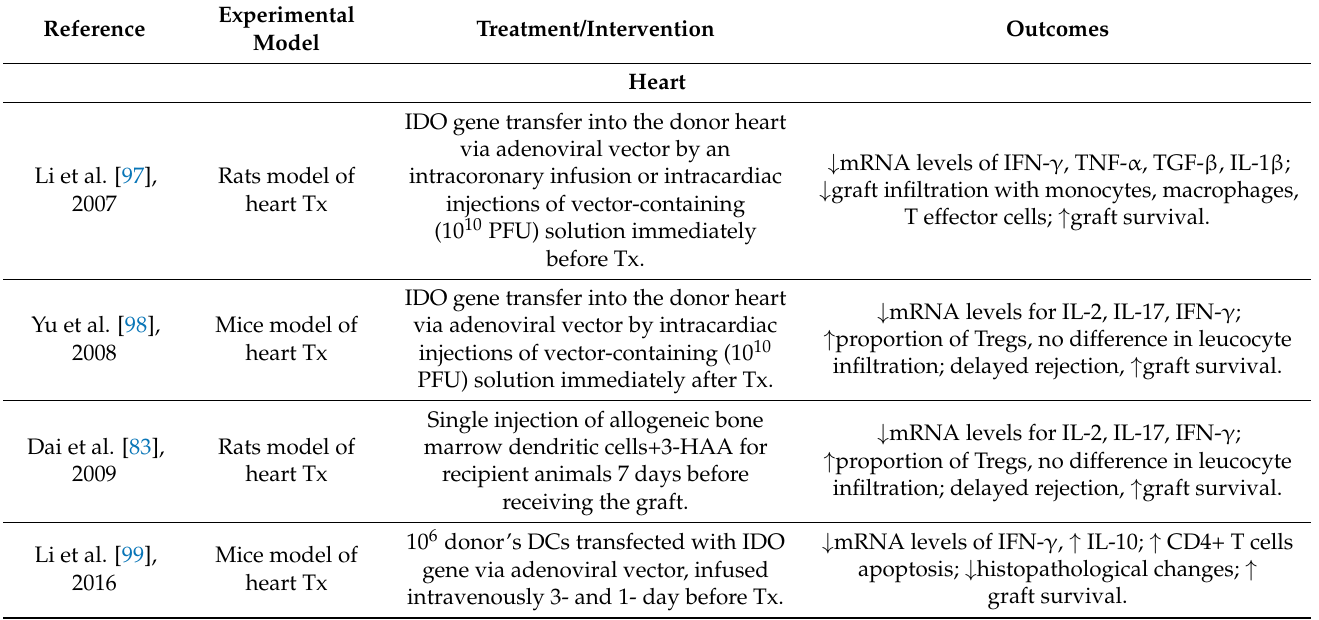
Table 2. Immunomodulatory effects of targeting the tryptophan-kynurenine pathway in animal models of solid organ transplantation